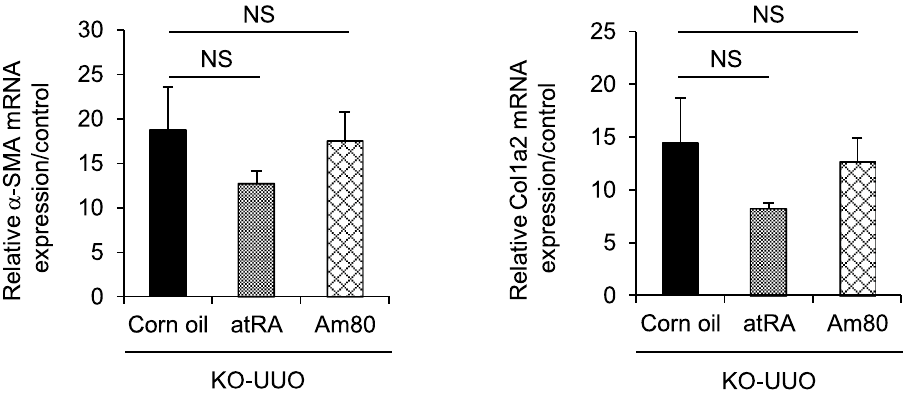
Figure 4. Am80 treatment fails to alleviate UUO-induced renal fibrosis in AGP-KO mice. The mRNA expression of α-SMA and Col1a2 in the UUO-treated AGP-KO mice were not significantly alleviated by Am80 administration (n = 4 for corn oil group; n = 5 for atRA or Am80